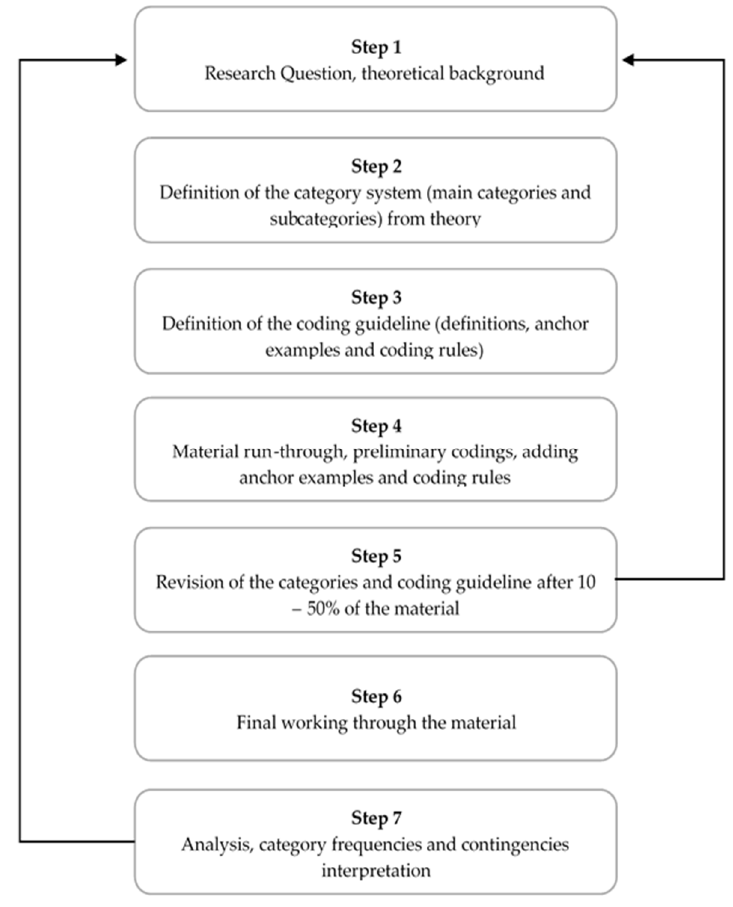
Figure 3. Exemplary steps of deductive category assignment according to Mayring (2014).